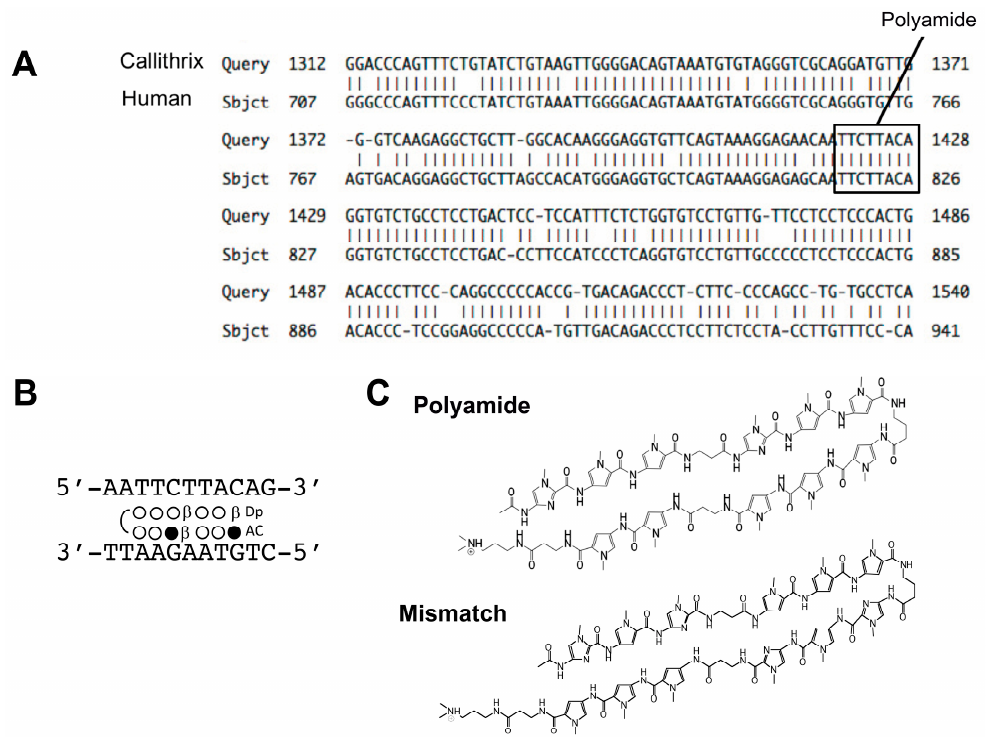
Figure 2. ( A ) The sequences of human and marmoset transforming growth factor (TGF)- β 1 promoter analyzed by an NCBI BLAST Two-Sequence Analysis. Binding sites (box) of pyrrole-imidazole (PI) polyamide on the human and marmoset TGF- β 1 promoter. ( B , C ) The structures and target sequences of PI polyamides targeting the human TGF- β 1 promoter and the structure of the mismatch polyamide. Open circle indicates pyrrole, and closed circle indicates imidazole.